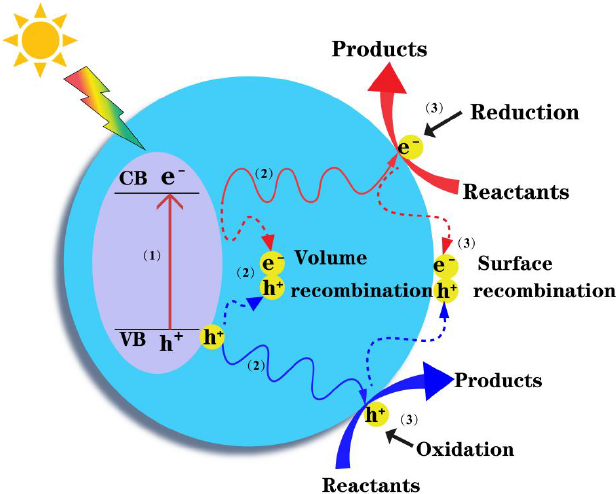
Scheme 1. The basic principle of photocatalysis over semiconductor photocatalyst.